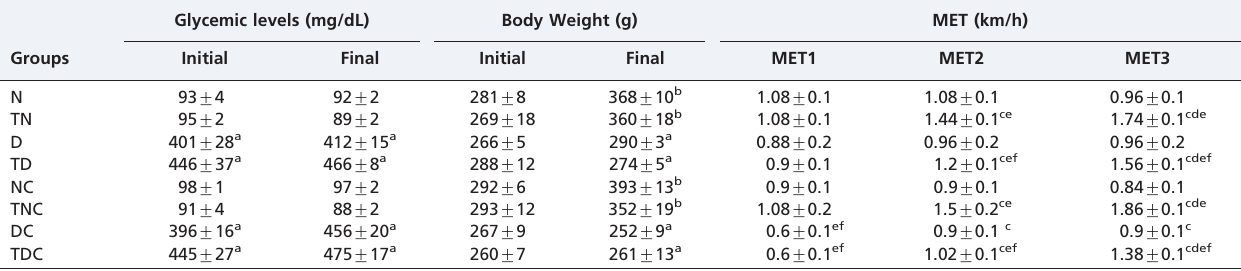
Data are reported as mean ¡ SEM. a P , 0.05 vs. N, TN, NC and TNC groups b P , 0.05 vs. initial in the same group c P , 0.05 vs. MET 1 in the same group